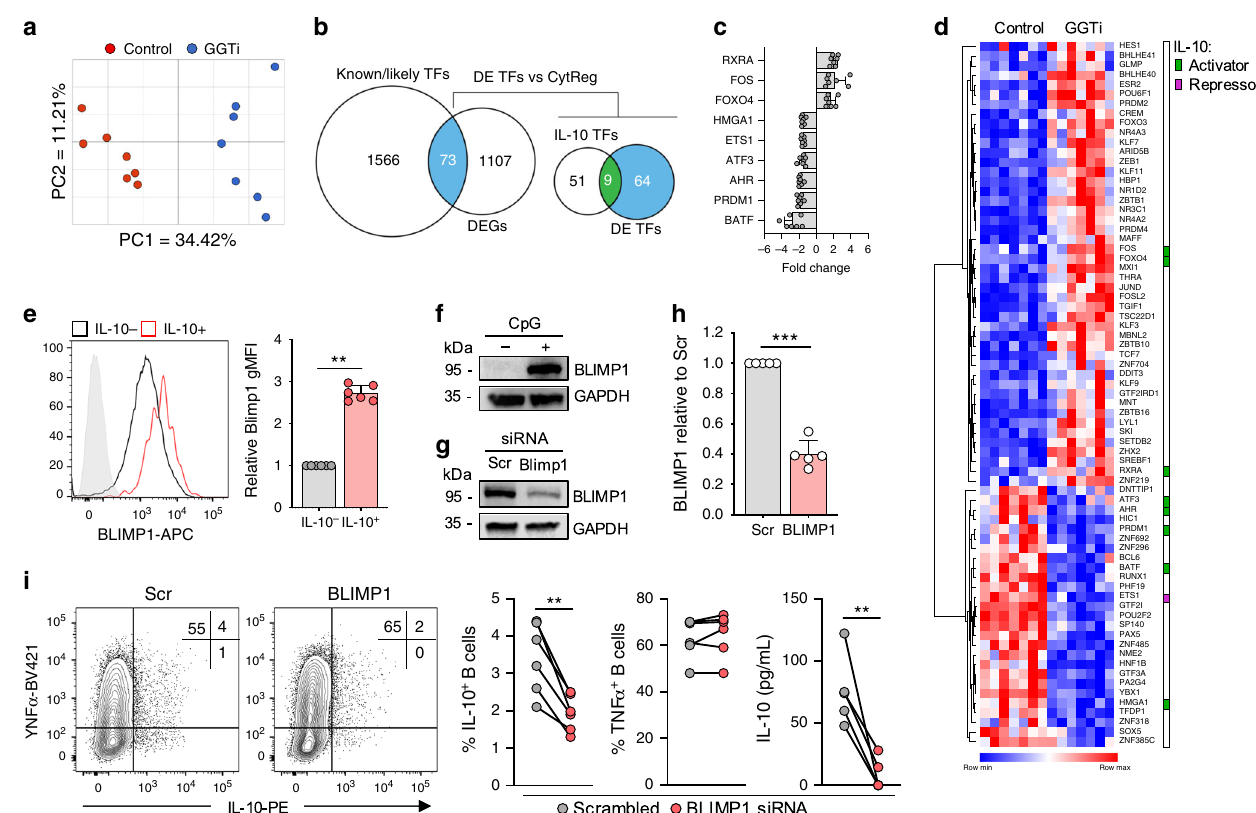
Fig. 5 GGPP regulates IL-10 induction via BLIMP1. a Principal component analysis of human B cells after stimulation through TLR9 ± geranylgeranyl transferase inhibition (GGTi), with analysis performed on total normalized counts generated from RNA-sequencing data, before statistical analysis ( n = 7). b Work fl ow for the identi fi cation of putative IL-10 transcription factors. First, differentially expressed genes were cross referenced with known or likely human transcription factors, and the subsequently identi fi ed differentially expressed transcription factors were cross referenced with previously validated IL-10 transcription factors in either macrophages or T cells. Differentially regulated IL-10 transcription factors are shown in ( c ) and all differentially regulated transcription factors are shown in ( d ) ( n = 7). e Expression of BLIMP1 in human B cells within either IL-10 + or IL-10 − B cells after stimulation through TLR9 ( n = 6, pval = 0.003). f Western blot showing BLIMP1 expression in human B cells either in unstimulated or stimulated through TLR9 (CpG) after 40 h (representative of three independent experiments). g , h Western blot showing expression of BLIMP1 in human B cells after stimulation of TLR9 and nucleofection with either a scrambled control (Scr) or BLIMP1 siRNA ( n = 5, pval = 0.001). i IL-10 and TNF expression in human B cells stimulated through TLR9 after nucleofection with either Scr or BLIMP1 siRNA ( n = 6 for fl ow cytometry, pval = 0.002; and 5 for ELISA, pval = 0.009). Each data point represents individual donors. All data presented are mean ± SD where average values are shown. Statistical analysis in all fi gures was done using a paired t test. ** P < 0.01, *** P < 0.001 and all signi fi cant values are